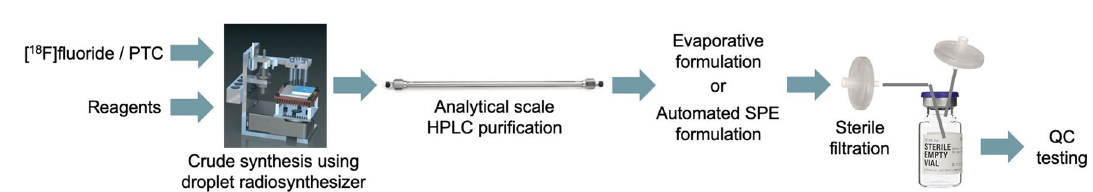
Figure 2. Tracer preparation scheme. PTC phase transfer catalyst, SPE Solid-phase